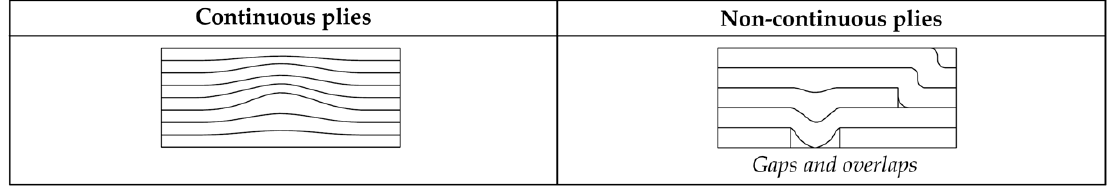
Figure 33. Waves at continuous vs. non-continuous plies.